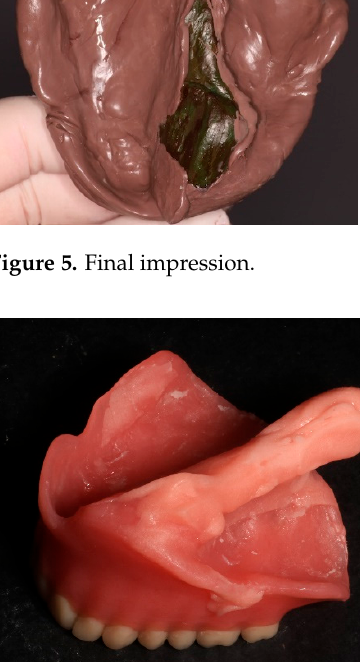
Figure 6. Tracing of the pharyngeal extension of the maxillary prosthesis.